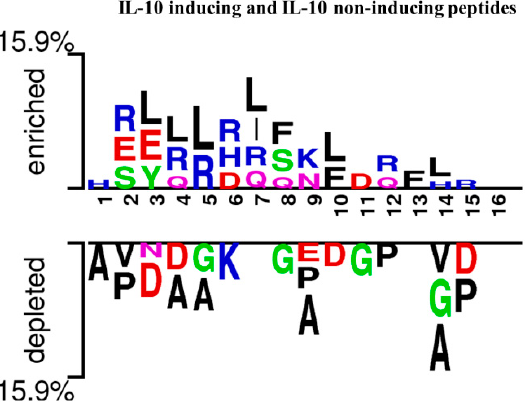
Figure 2. Two-sample logo showing the preference of positively charged and hydrophobic residues in IL-10-inducing peptides and non-IL-10-inducing peptides at different positions. The first eight positions represent the N-terminus of peptides, and the last eight positions represent the C-terminus of peptides.